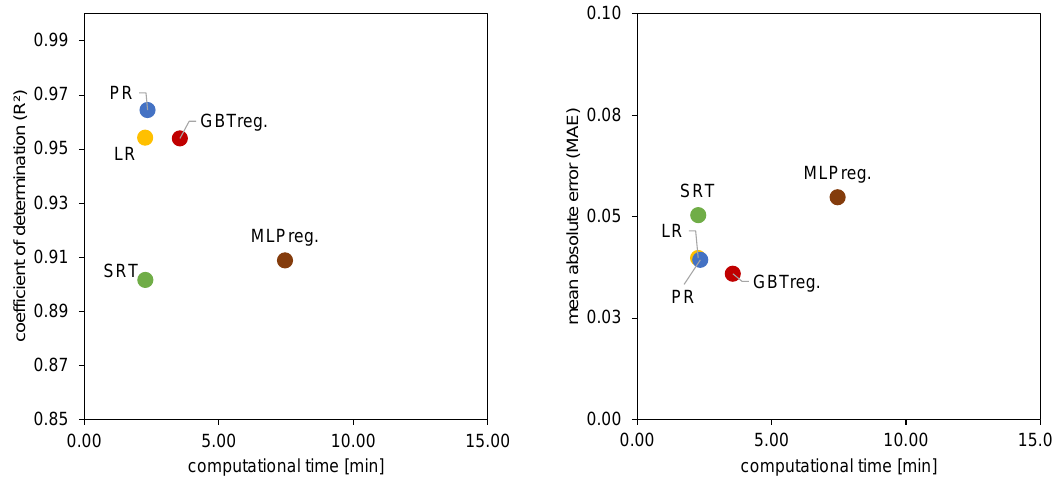
Figure 15. Evaluation of data mining results predicting the cooling capacity.